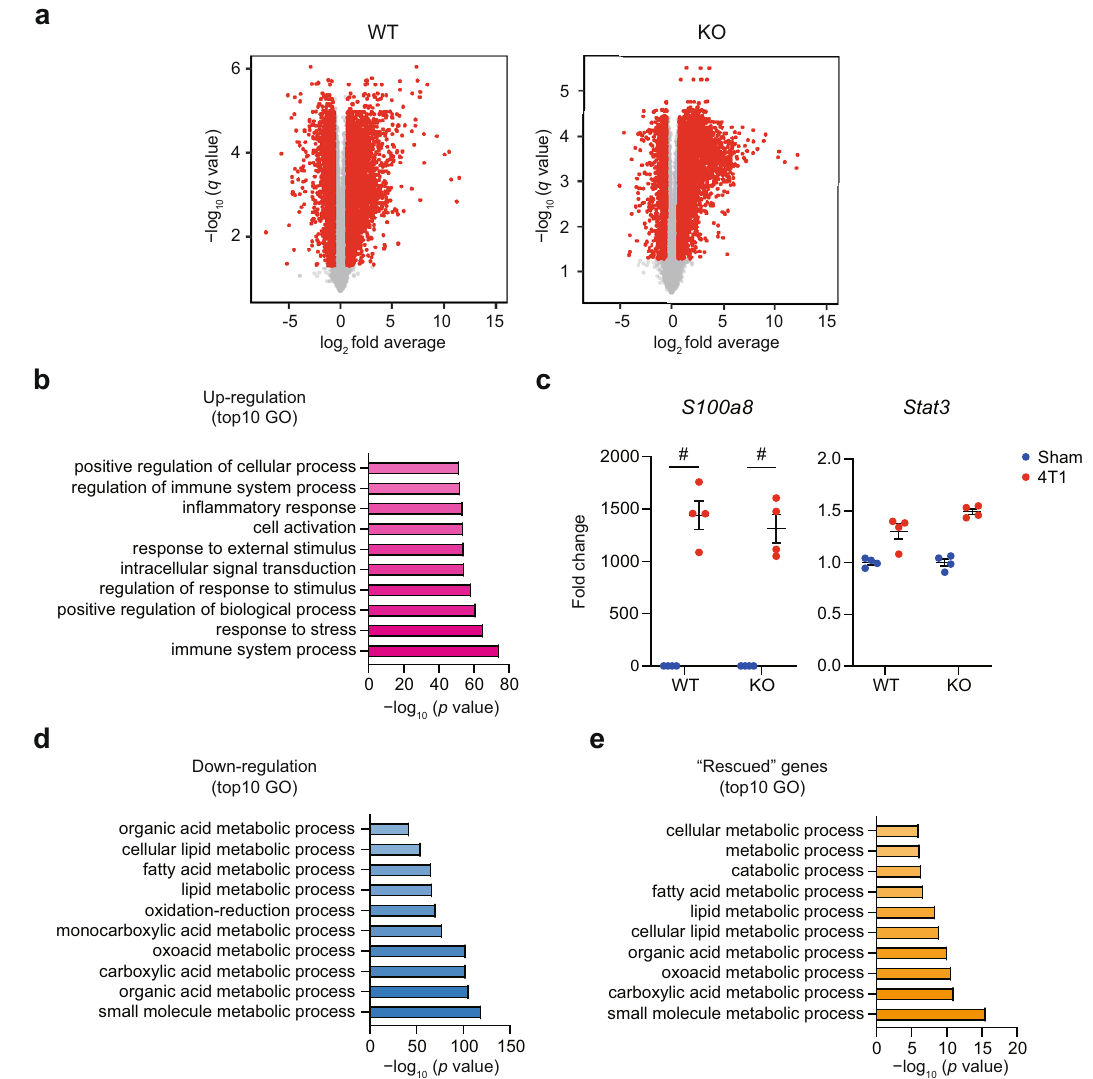
Fig. 3 Nnmt deletion buffers transcriptome changes caused by 4T1. a RNA-seq experiments for the livers of sham-operated mice and 4T1-bearing mice in WT and Nnmt KO (14 days after 4T1 transplantation). Volcano plots (log 2 fold average (4T1/sham) versus – log 10 ( q value)) of WT (left) and Nnmt KO (right) are shown. Genes showing more than 1.5-fold change with q < 0.05 are highlighted in red. n = 4. b Gene ontology analysis (g:Pro fi er) for genes signi fi cantly elevated in the livers of 4T1-bearing mice. Adjusted enrichment p values obtained from g:Pro fi er are shown. c RNA-seq results of representative upregulated genes S100a8 and Stat3 . Averaged fold change data normalized to the sham group in each genotype are presented as the mean ± SEM. #; more than 1.5-fold change with q < 0.05. n = 4. d Gene ontology analysis (g:Pro fi er) for genes decreased in the livers of 4T1-bearing